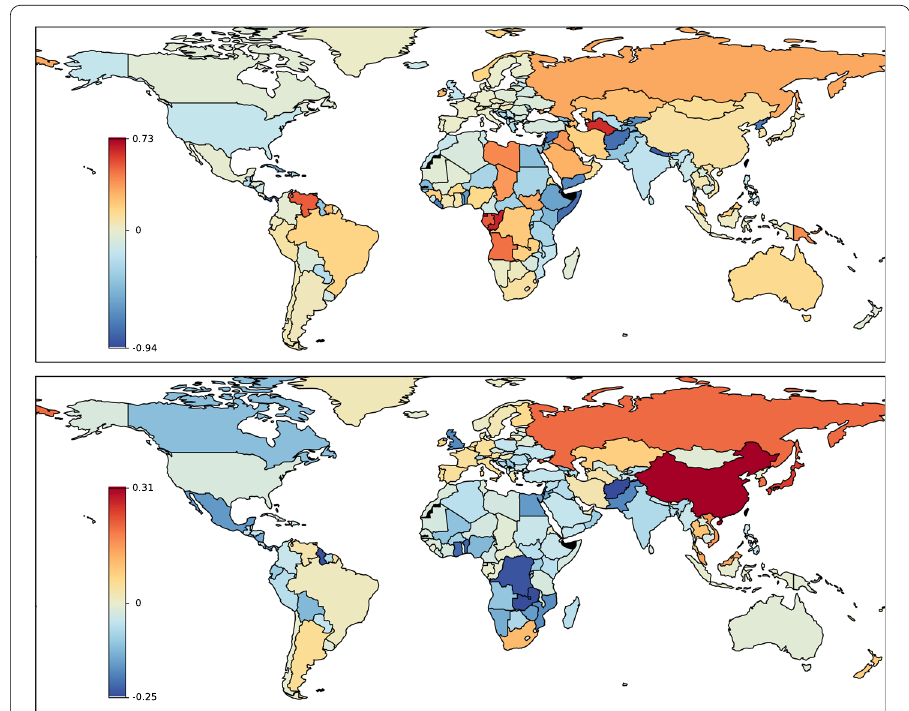
Fig. 2 World map of trade balance. World map of probabilities balance B c = ( P c ∗ − P c )/( P c ∗ + P c ) of countries. Top panel: probabilities are computed from the trade volume of Export–Import. Bottom panel: probabilities are computed from PageRank and CheiRank vectors. Data are shown for year 2018 (similar data for years 2012, 2014, 2016 are given in Additional file 1: Fig. A2). Balance values are marked by color with the corresponding color bar ( j ); countries absent in the UN COMTRADE report are marked by black color (here and in other